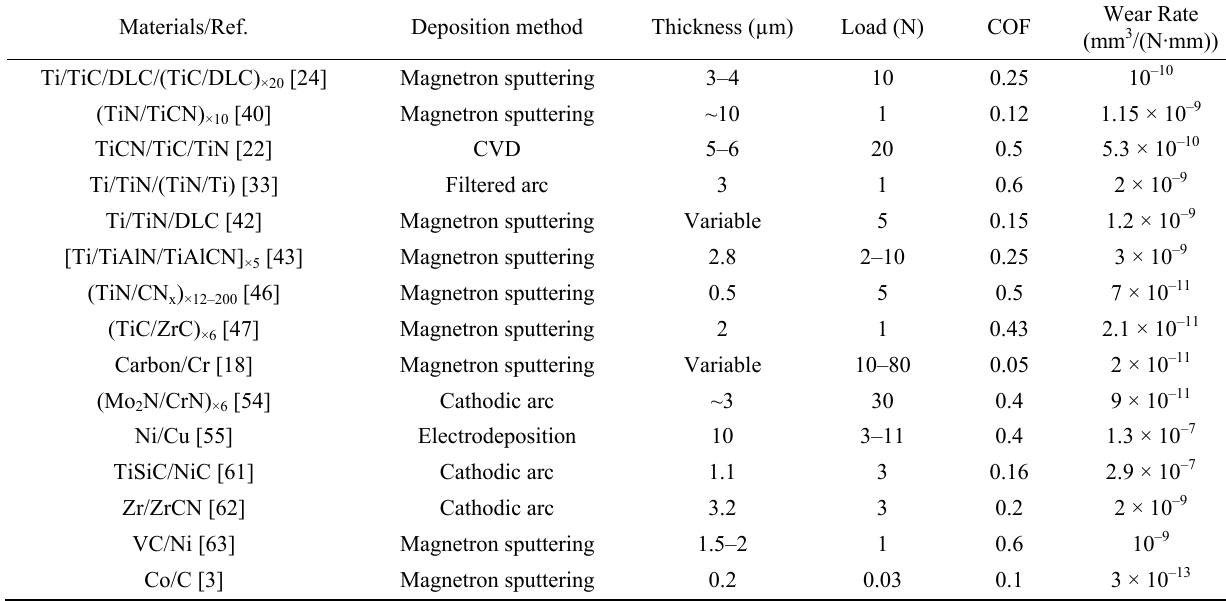
Table 2 Friction and wear properties of selected multilayer coatings.